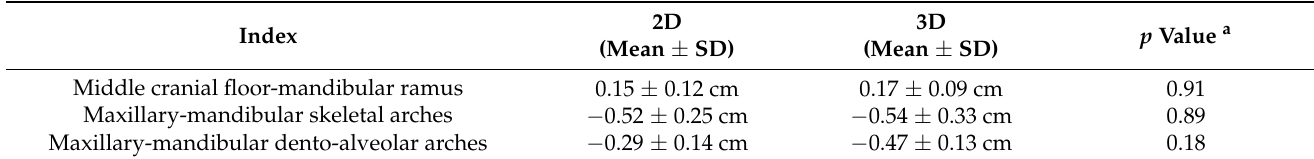
Table 3. Comparing discrepancies of the horizontal counterpart analysis between 2D and 3D parameters.